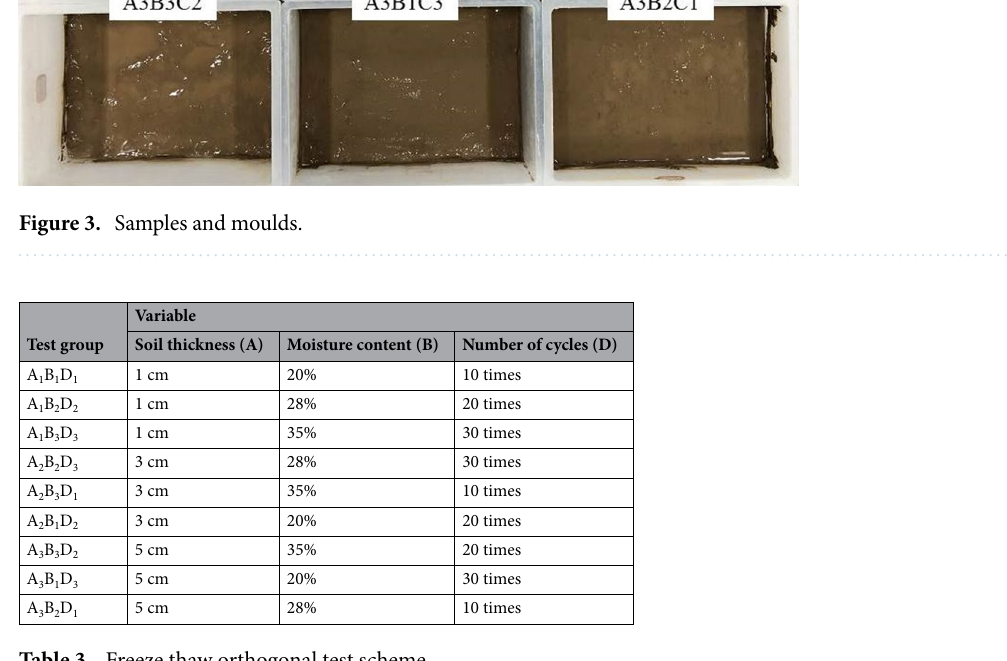
Table 3. Freeze thaw orthogonal test